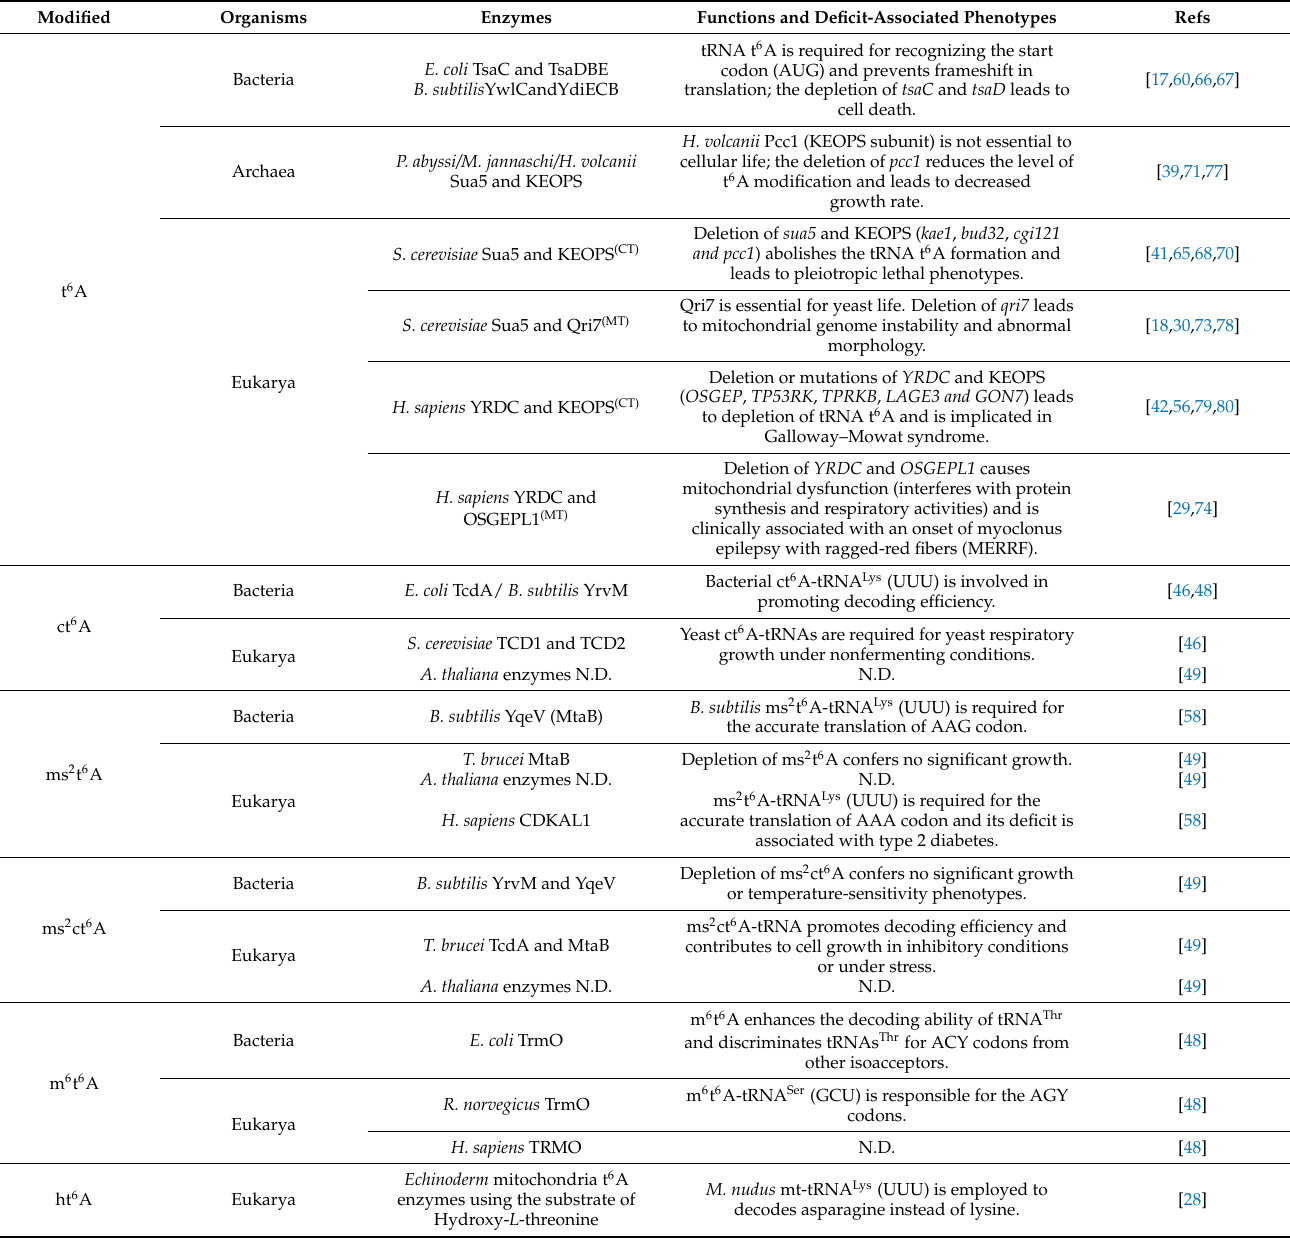
Table 1. Summary of the biosynthetic enzymes of tRNA t 6 A and other related tRNA t 6 A hypomodi- fied nucleosides found and validated in different organisms. Abbreviations: TsaDBE,